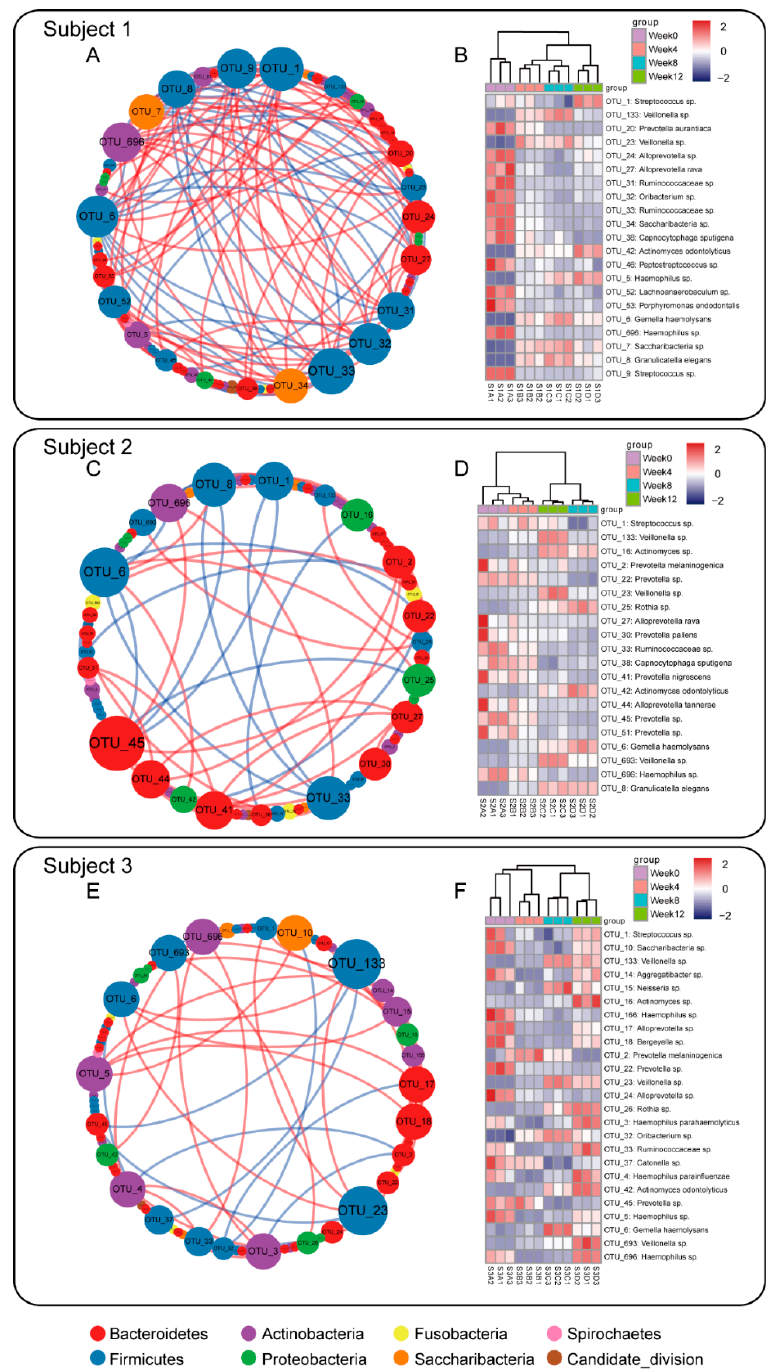
Figure 3. Correlation networks of the predominant salivary microbiota ( A, C, and E ) and heatmaps of the hub salivary microbiota ( B, D, and F ) in each subject. In correlation networks, each node represents an OTU; the color of nodes indicates the phylum information; the size of nodes represents the number of linkages; lines between nodes represent a strong correlation between these two OTUs (|r| > 0.9 and p < 0.05, Pearson’s correlation); red line represents a positive correlation and blue line represents a negative correlation. The nodes with high strong connection numbers were selected as the “hub microbiota” and their dynamic shifts of relative abundance were further depicted on heatmaps. The color of the data matrix in heatmaps corresponds to the normalized relative abundance of the OTUs; the color bar on the top right indicates the scale.